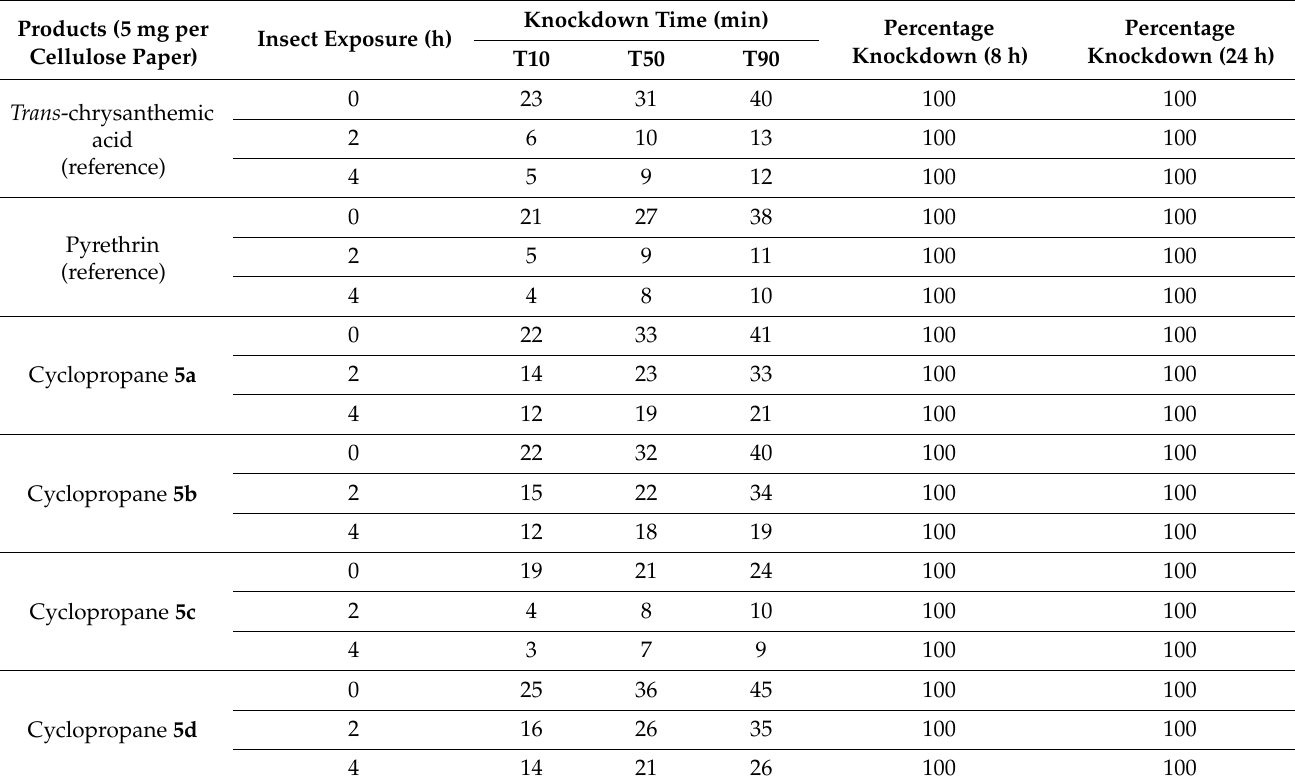
Table 2. Effects of cyclopropanes 5a–d versus trans -chrysanthemic acid and pyrethrin in the vapor phase against Aedes aegypti .